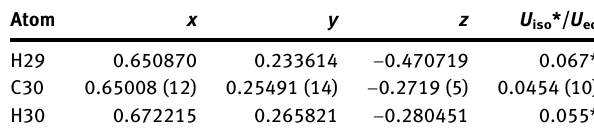
Table  : Fractional atomic coordinates and isotropic or equivalent isotropic displacement parameters (Å 